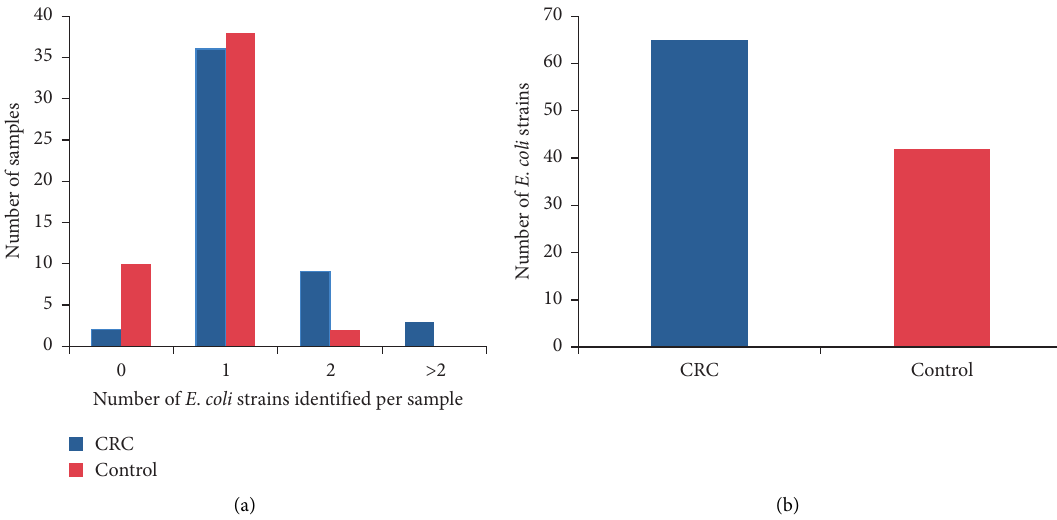
Figure 1: Number of E. coli strains obtained from 100 subjects comprising 50 CRC patients and the equivalent number of control subjects. (a) Some specimens did not carry any strain of E. coli and some specimens carried one or more than one E. coli strains. (b) A total of 65 E. coli strains from CRC patients and 42 E. coli strains from the control group